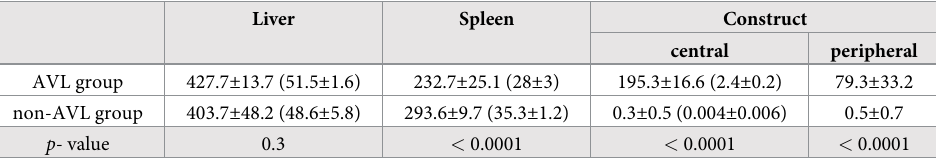
Table 3. Detected labelled cells among different tissues; cell/ROI (cell/mm 2